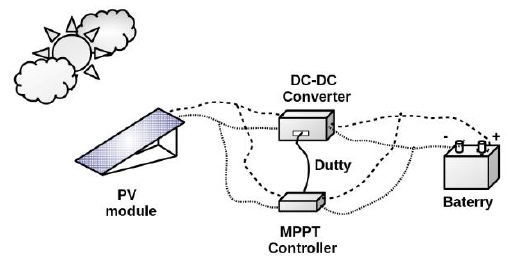
Figure 2. Components of the PV system.